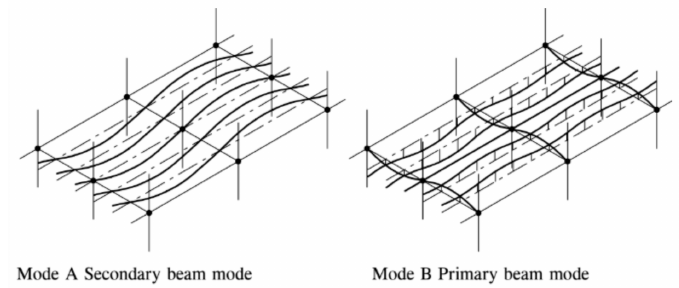
Figure 5. Mode A and Mode B (SCI Design